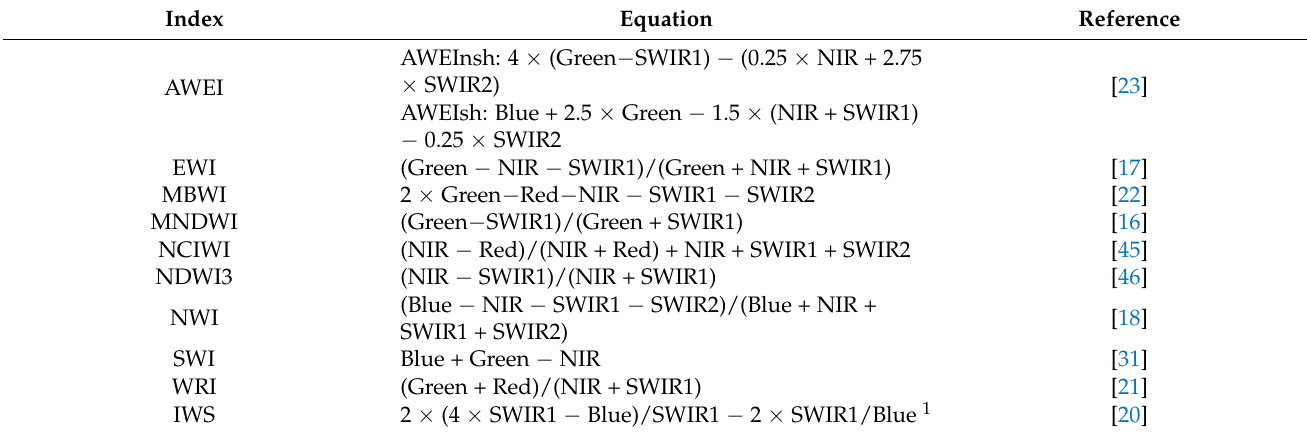
Table 4. Calculation equation and source references for representative water